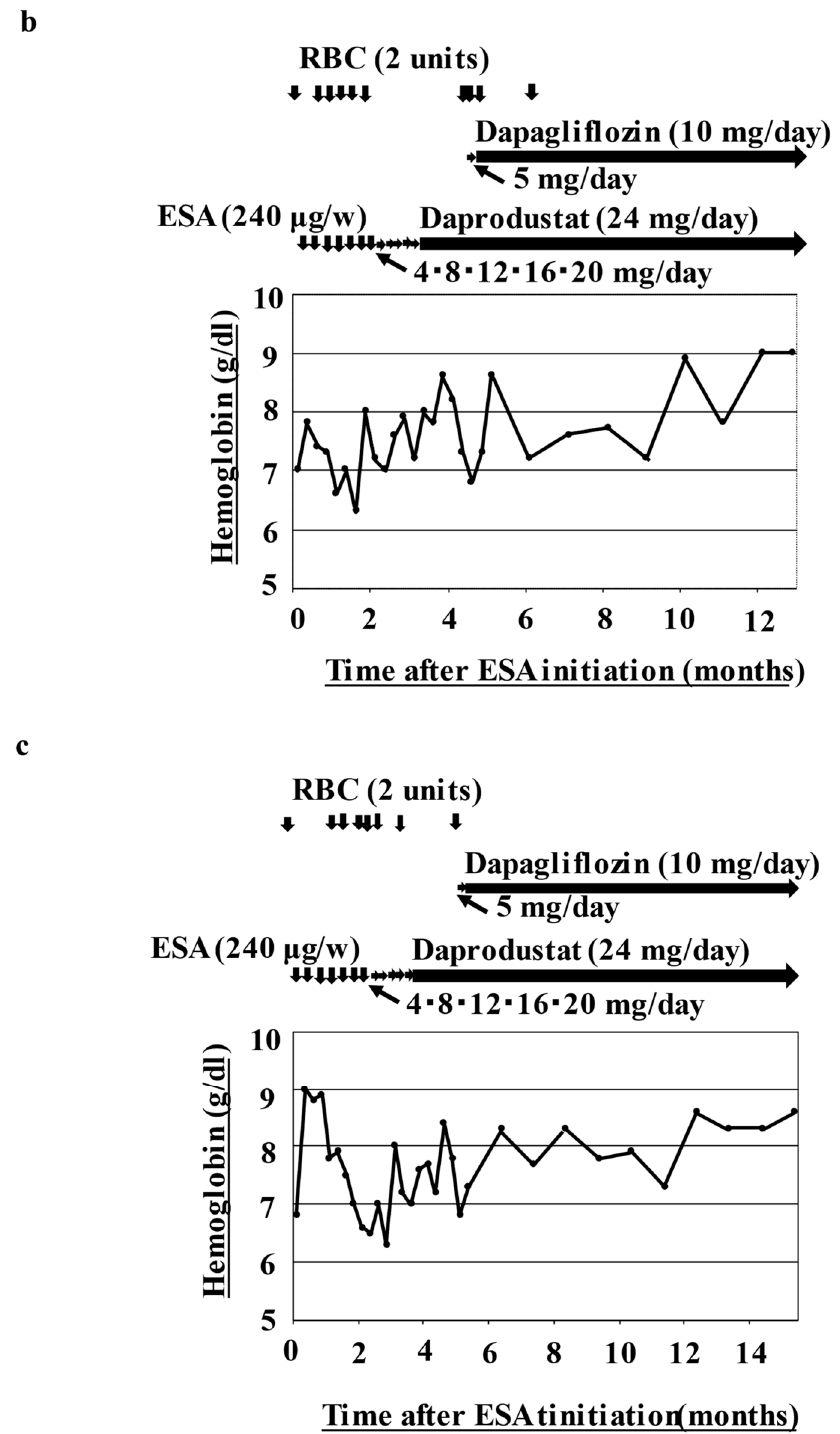
Figure 1. Changes in hemoglobin concentrations and treatment administered. After initiation of erythropoiesis-stimulating agents, the patients’ hemoglobin concentrations began to improve. The upper panels show the frequency of red blood cell transfusion and treatments administered, while the lower panels show the hemoglobin concentrations (( a ), case 1; ( b ), case 2; ( c ), case 3). ESA, erythropoiesis-stimulating agent; RBC, red blood cell; w, week.